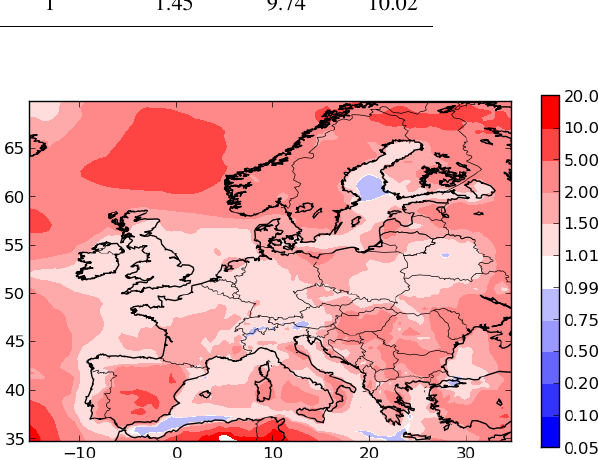
Figure 11. Equilibrium deviation for compound SOAhP. A devia- tion close to 1 means that the compound reaches equilibrium, above 1 means that particle-phase concentrations are above equilibrium and under 1 means that concentrations have not reached equilib-